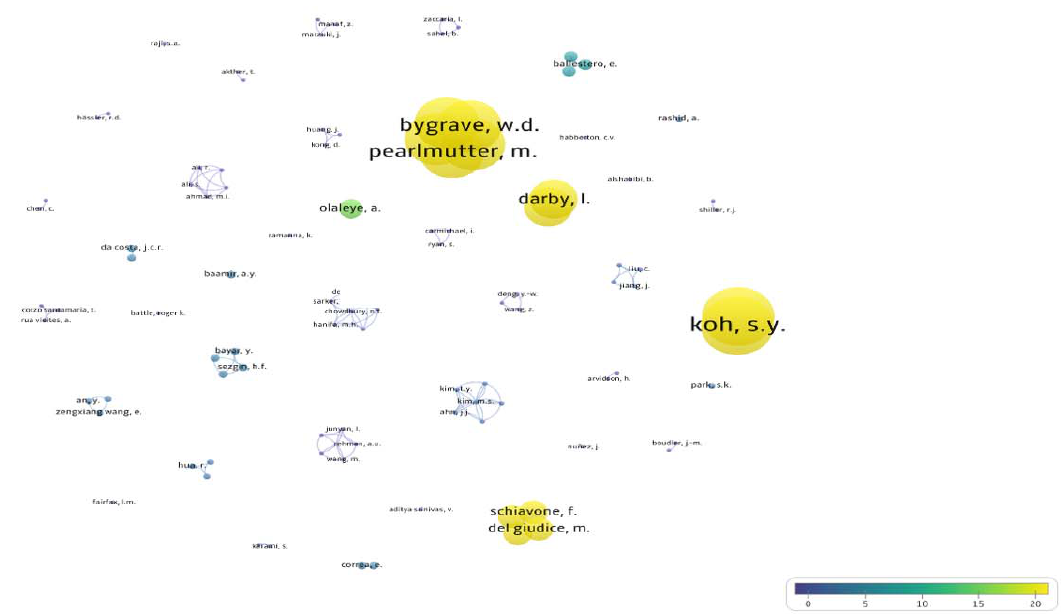
Figure 6. Visual representation of bibliographic coupling; Citation.